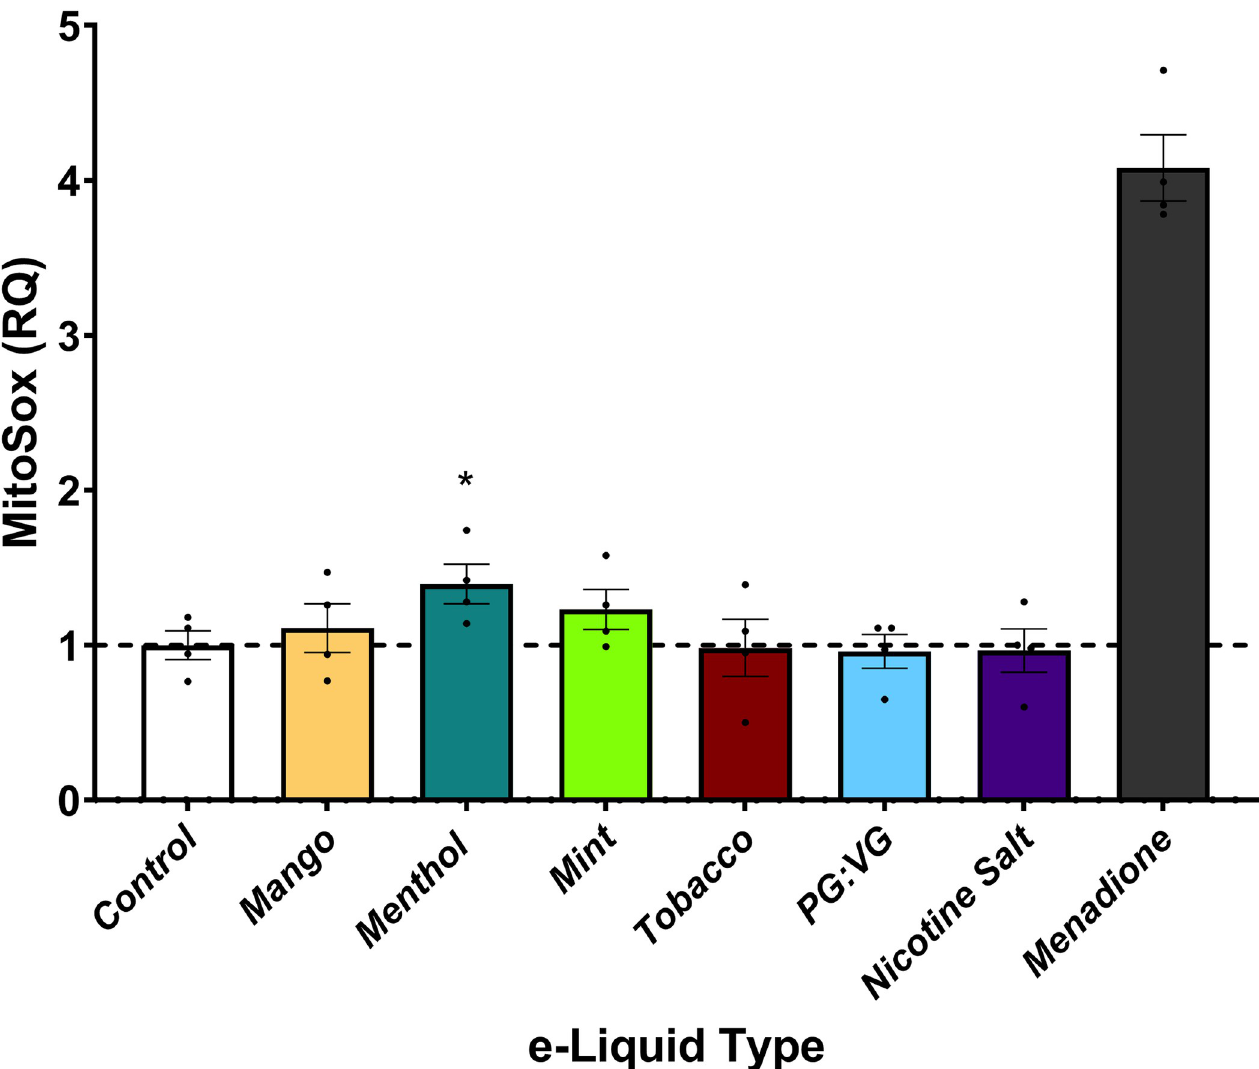
Fig 6. Menthol-containing JUUL e-liquids induce oxidative stress. MitoSox fluorescence was quantified in HAECs exposed to 1 x 10 − 5 % dilutions of JUUL e- liquids, and the constituents PG:VG and nicotine salt (n = 4). Each e-liquid was compared to control. Data are expressed as fluorescence intensity normalized to control, dots represent individual experiments, columns and error bars are mean and SEM. � indicates p <